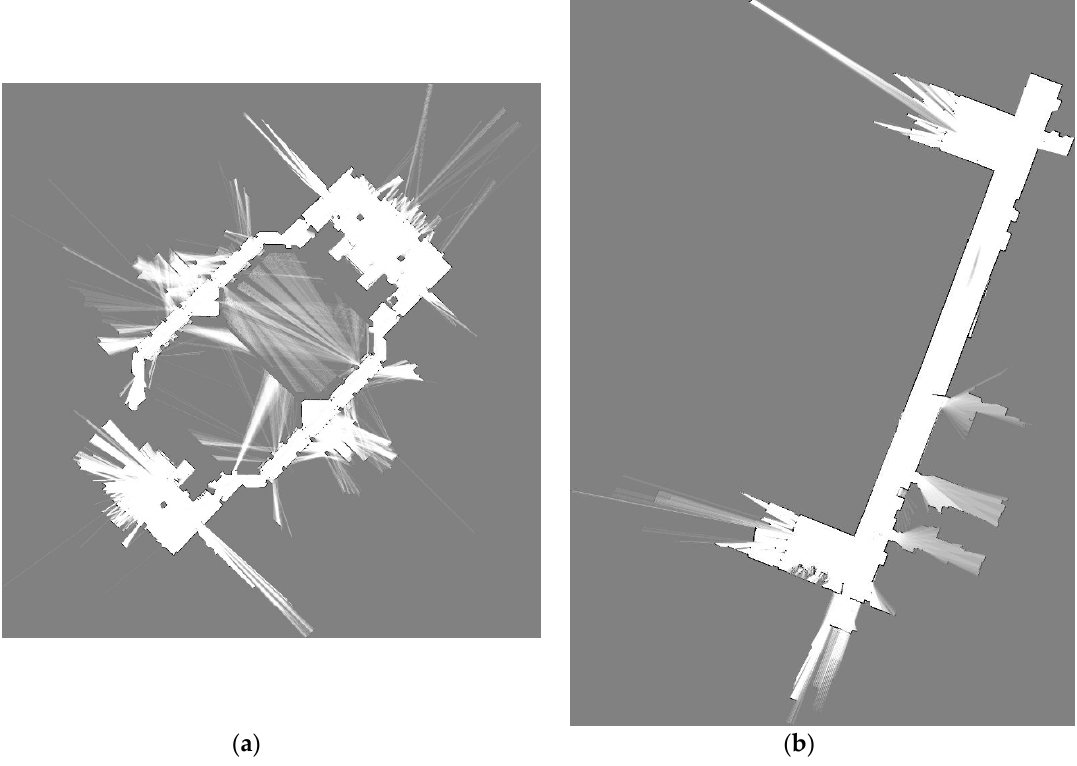
Figure 11. The map generated with the proposed method in indoor environment. ( a ) mapping result of first floor of teaching building No. 9; it is a closed-loop classroom corridor, but we deliberately arranged to not use the last section data, and the mapping result is acceptable. ( b ) mapping results of the first floor of teaching building No.1.